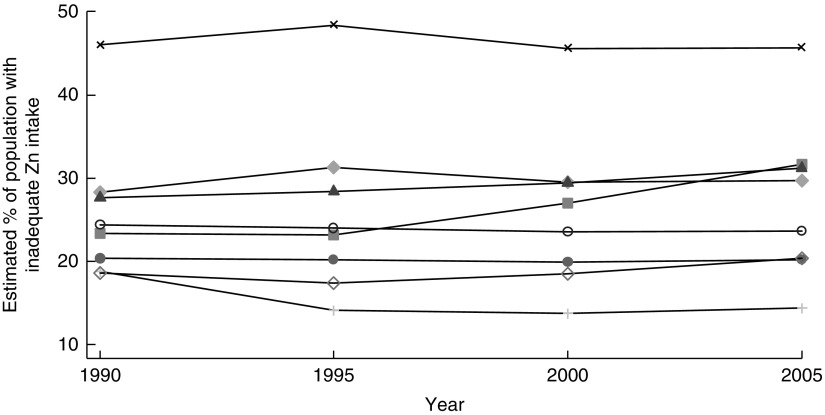
Trend in inadequate zinc intake between 1990 and 2005 in South Asia, by country:
, Afghanistan; ,
Bangladesh; , Bhutan; ,
India; , Maldives; ,
Nepal; , Pakistan; ,
Sri Lanka. (Data from Wessells and Brown(

6

))